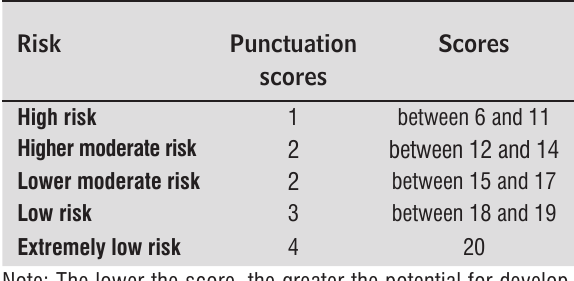
Table 1 - Classification of patient's risk of developing pressure ulcers